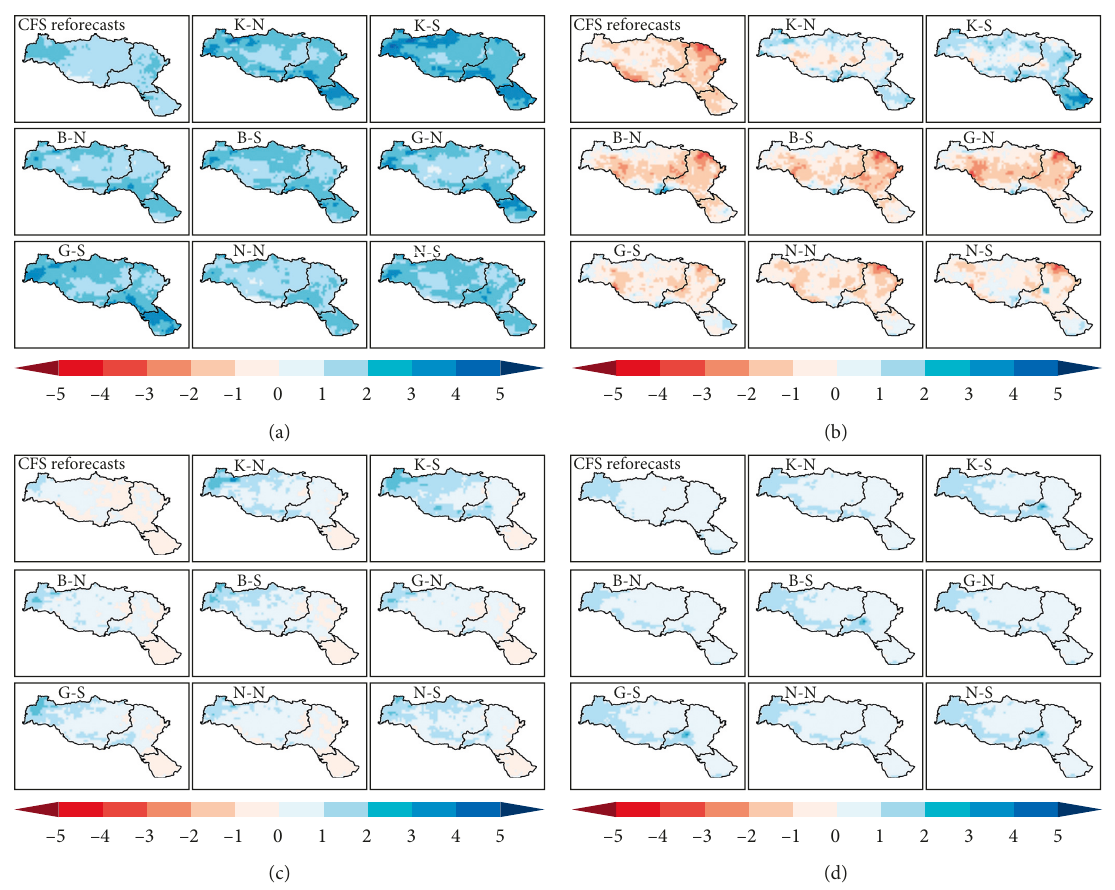
Figure 3: Spatial patterns of biases of CFS reforecasts and the WRF model for the period of 1999–2010 in (a) spring, (b) summer, (c) autumn, and (d) winter